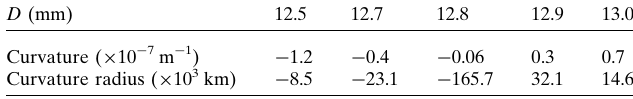
Table 1 Curvature and curvature radius for different values of D . Combined with Fig. 4, negative curvature represents convex thermal deformation, positive curvature represents concave thermal